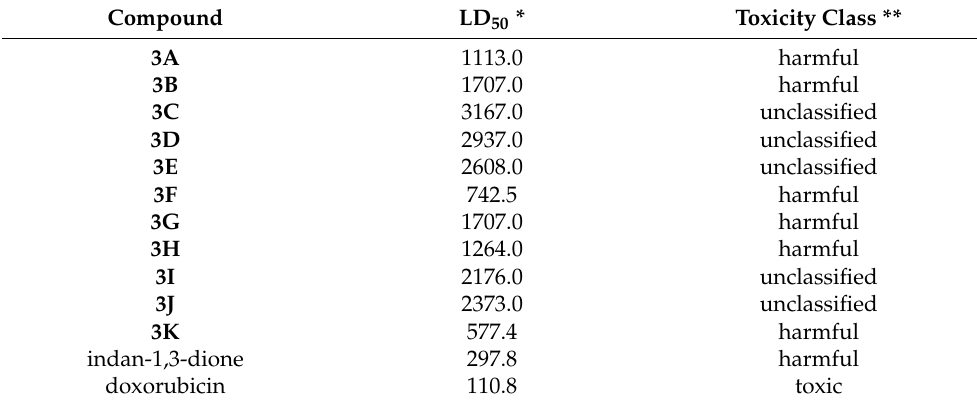
Table 4. In silico LD 50 values are determined and the compounds are classified according to their acute